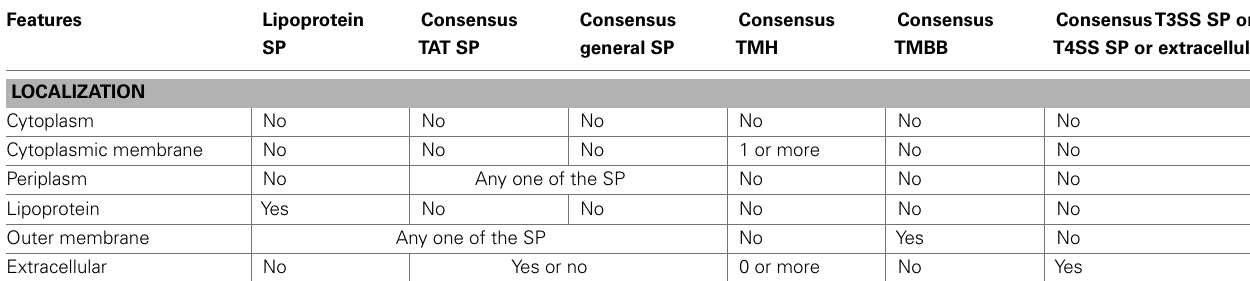
Table 2 | Logic for SCL prediction at the protein